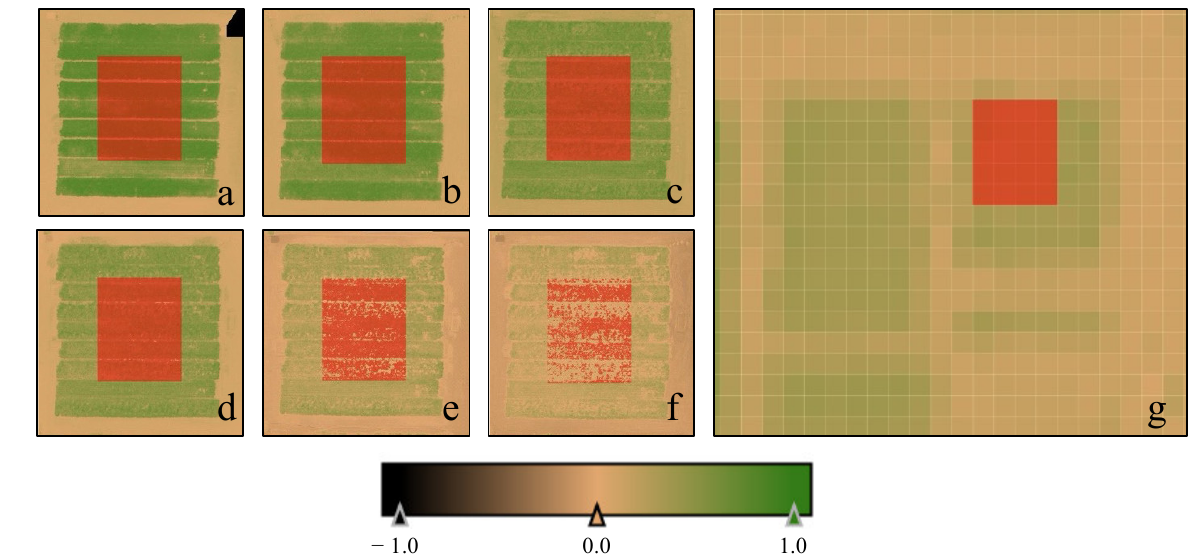
Figure 8. UAS NDVI rasters clipped to a 50 m × 40 m region within the eastern field of the irrigation